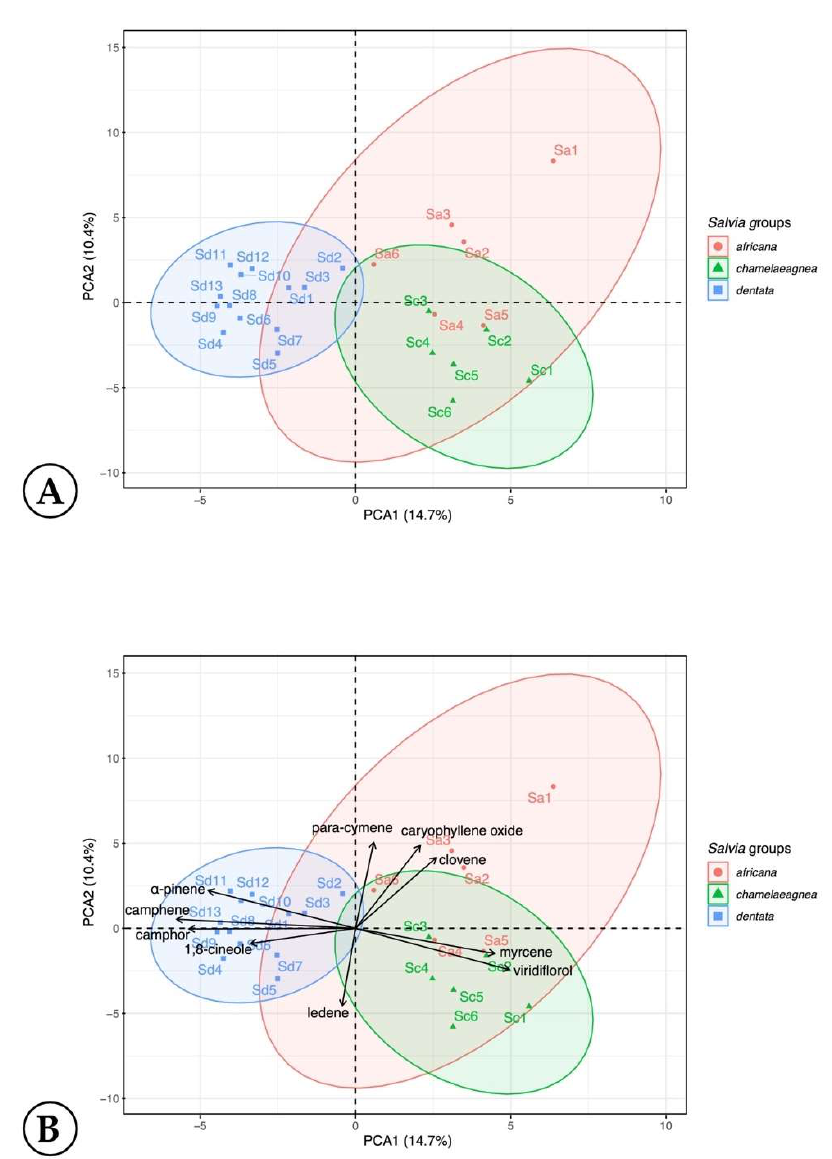
Figure 7. Principal component analysis (PCA) scatterplot (biplot) of the first (14.70%) and second (10.40%) components; ( A ) scatterplot of species and ( B ) scatterplot of the essential oils (loadings